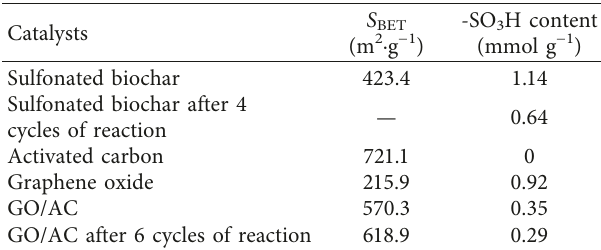
Table 1: Specific surface areas and sulfonic acid group (-SO content of the catalysts.